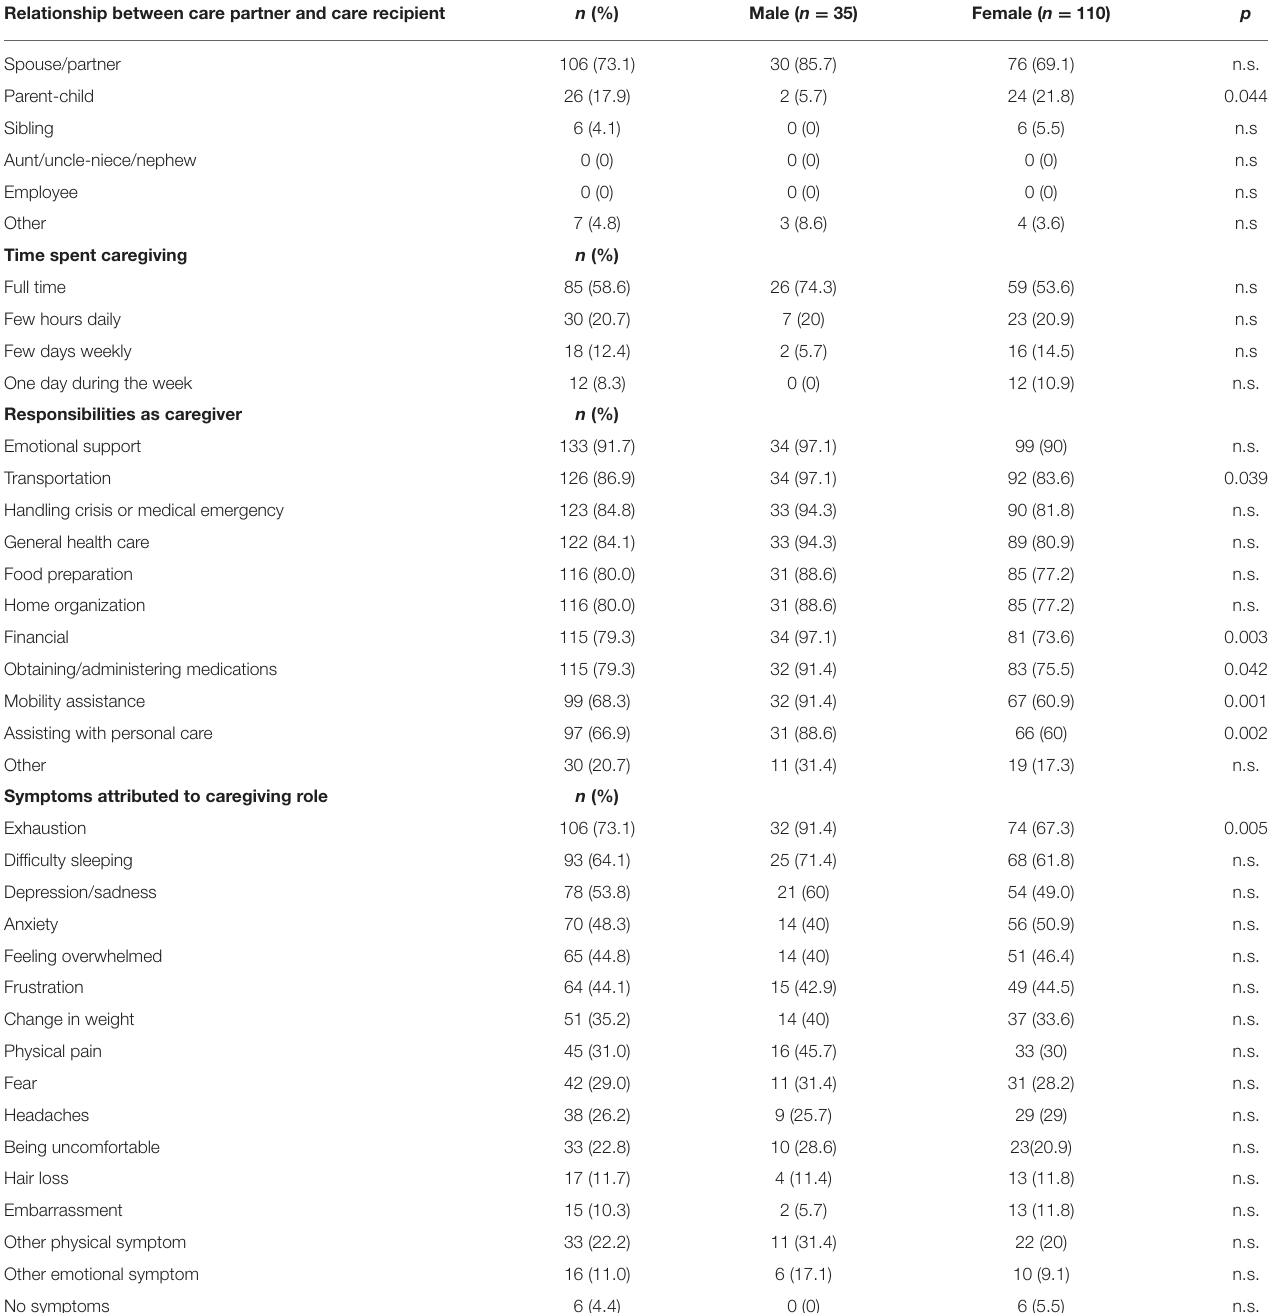
TABLE 1 | Demographics of respondents, caregiving roles, and symptoms attributed to caregiving ( N = 145). Relationship between care partner and care